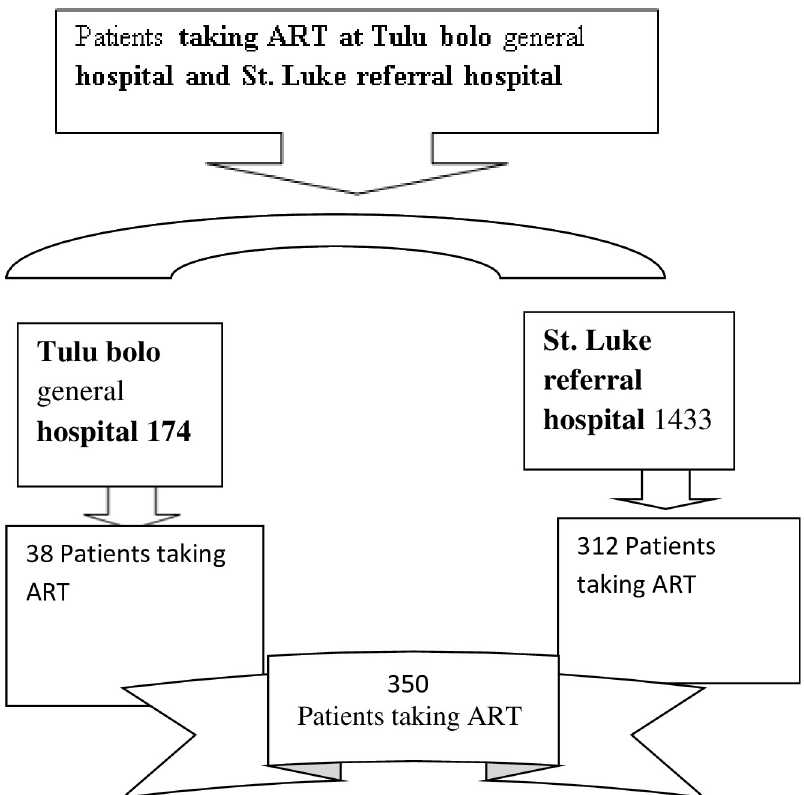
Fig 1. Schematic presentation of proportional allocation of patients taking ART at public health facilities in South West Shoa Zone, 2019.